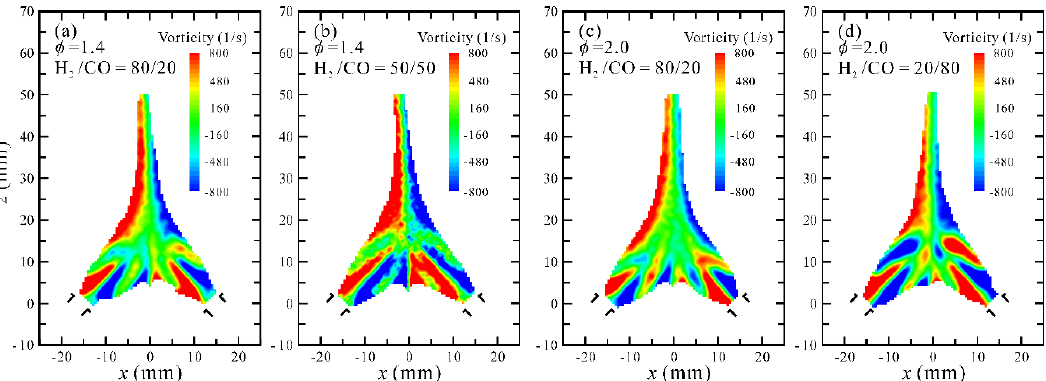
Figure 8. Velocity distribution of CH 4 /syngas/air premixed impinging flames: ( a ) φ = 1.4 and H 2 /CO = 80/20; ( b ) φ = 1.4 and H 2 /CO = 50/50; ( c ) φ = 2.0 and H 2 /CO = 80/20; ( d ) φ = 2.0 and H 2 /CO = 20/80.